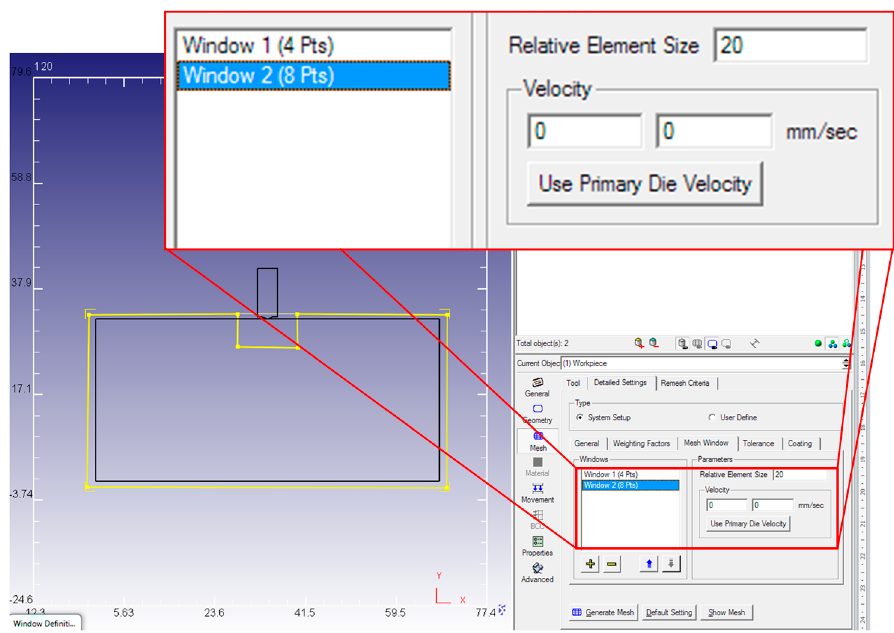
Figure 5. Mesh window display.